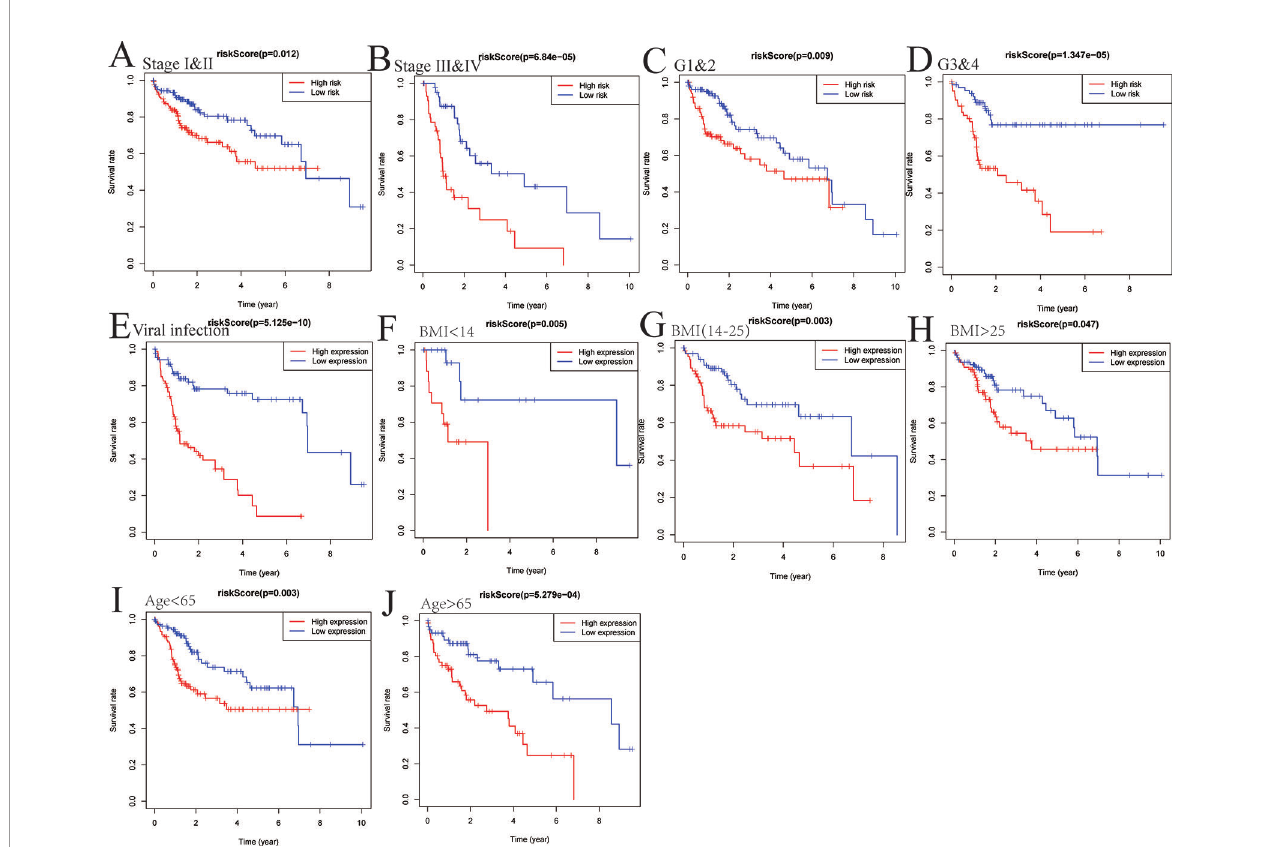
FIGURE 6 | The six-gene-based risk score is a promising marker for overall survival (OS) in subgroups. Subgroup analysis of OS based on pathological staging (A , B) , grading (C , D) , viral hepatitis (E) , BMI (F – H) , and age (I , J) of hepatocellular carcinoma (HCC)